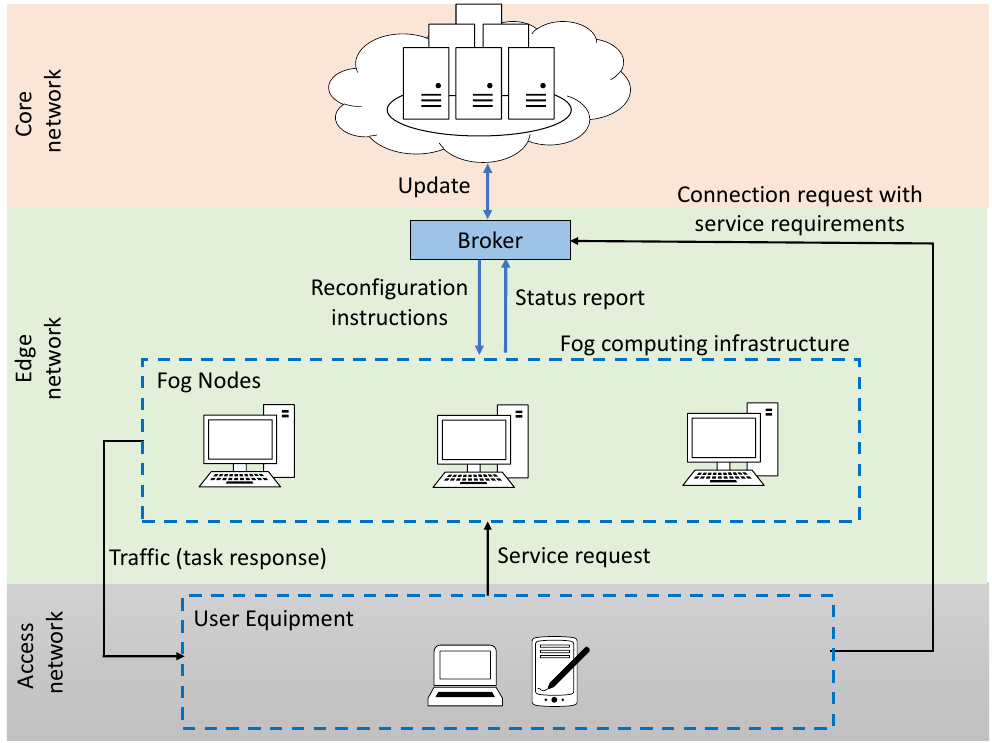
Figure 1. System model of